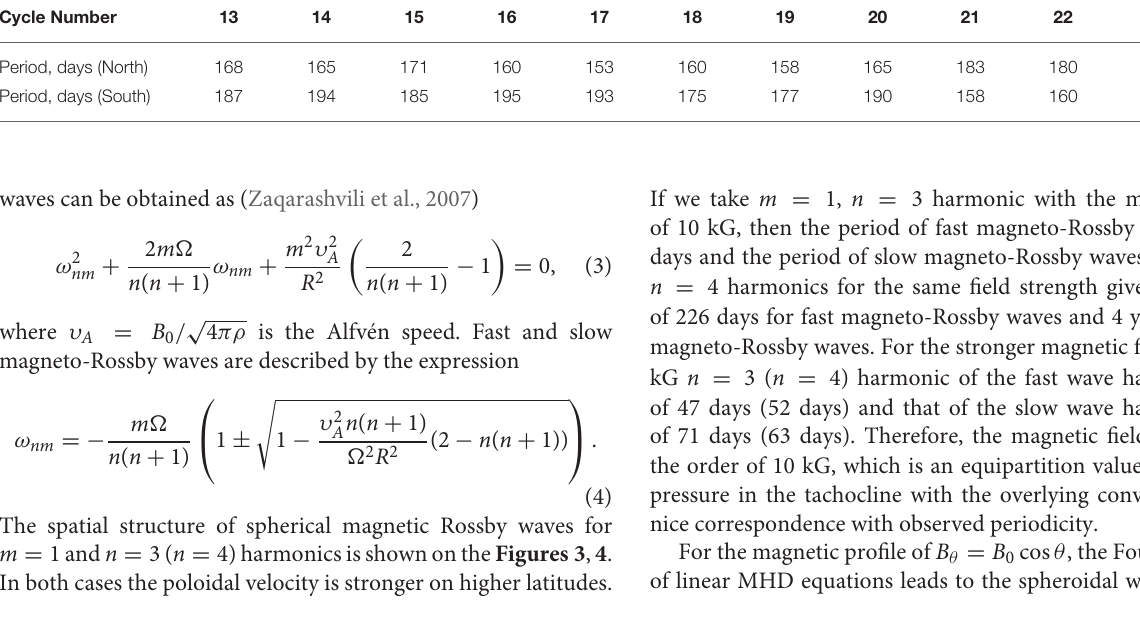
TABLE 1 | Estimated Rieger periods (days) for northern and southern hemispheres from GRO sunspot area data for solar cycles 13–24. Cycle